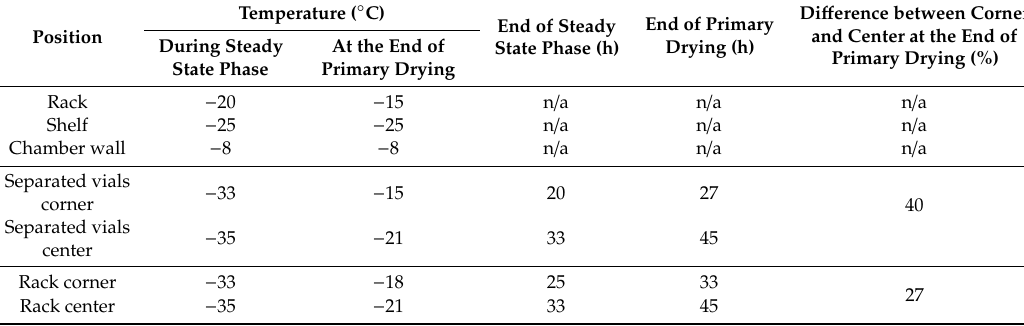
Figure 4. T P of separated vials compared to T P of vials in the rack. Definition of separated vials: vials positioned on a shelf with the aid of the rack but with the rack removed after positioning. Table 3. Measured T P in the rack compared to separated vials.